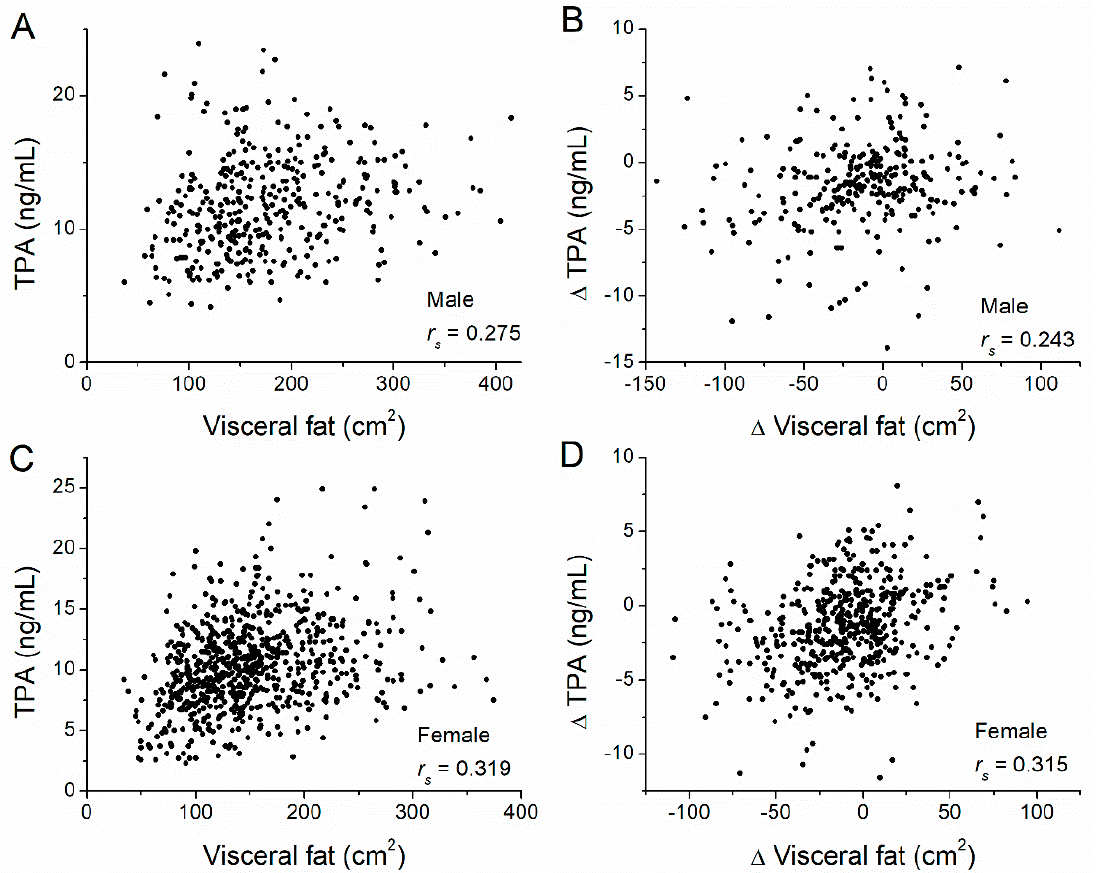
Figure 1. Correlations between visceral adipose tissue (VAT) volume and TPA levels, and between their changes. Correlations between ( A ) VAT and the TPA level ( r s = 0.275, p < 0.001), and between ( B ) changes in VAT and changes in TPA levels ( r s = 0.243, p < 0.001) in male participants of the diabetes prevention program. Correlations between ( C ) VAT and the TPA level ( r s = 0.319, p < 0.001), and between ( D ) changes in VAT and changes in TPA levels ( r s = 0.315, p < 0.001) in female partici- pants. Adipose tissue volume was measured at baseline and the one-year follow-up by computed tomography at the L4–L5 level. Δ = value (year 1) − value (baseline) , where values correspond to fat volume or TPA. The Spearman’s rank correlation coefficient, r s , was calculated.